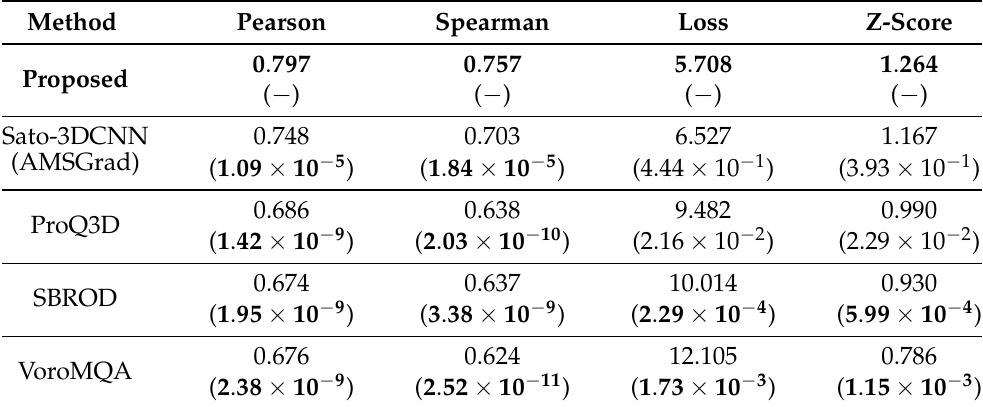
Table 4. Performance in the CASP13 stage 2 test